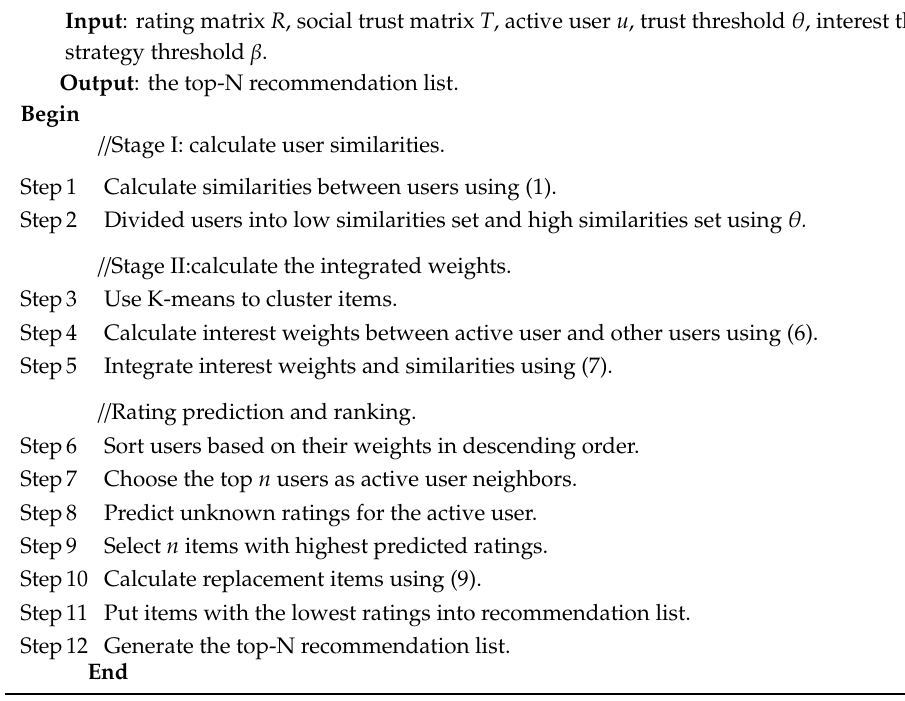
Algorithm 1 . Diversity Balancing for Two-Stage collaborative filtering